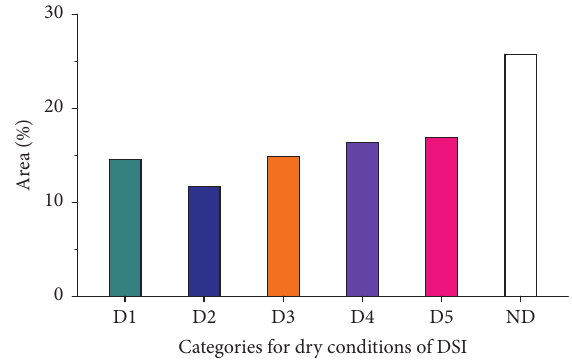
Figure 3: Drought areas quantified by the averaged monthly DSI from November 2009 to March 2010. D1 = incipient drought; D2 = mild drought; D3 = moderate drought; D4 = severe drought; D5 = extreme drought; ND = no